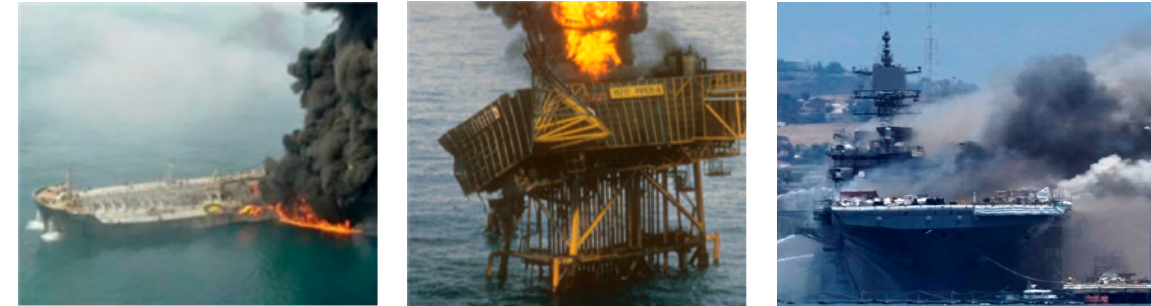
Figure 1. Sanchi oil tanker ( left ), Piper Alpha ( middle ) and U.S.S. Bonhomme Richard ( right ) accidents.